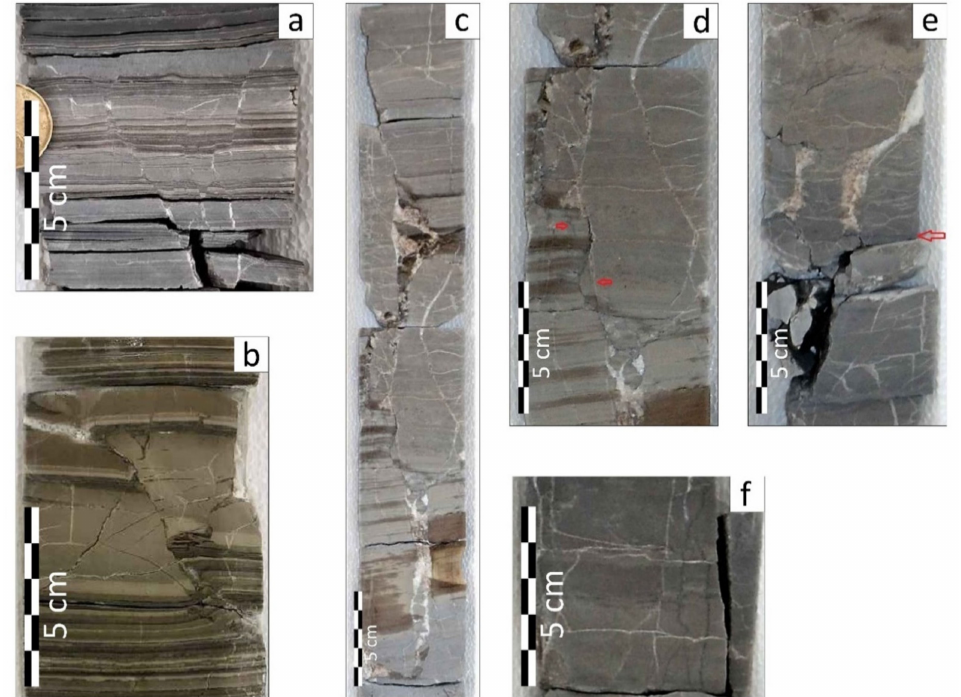
Figure 11. Examples of ( a ) normal micro-faults with small horst and grabens; ( b ) a reverse micro-fault with an 18 mm offset. Partially cemented fractures are also present; ( c ) a portion of the 2111–2112 core containing the normal fault, cemented by calcite and angular clasts, reminiscent of a damage zone; ( d ) a tectonic stylolite cutting a fracture (red arrows indicate stylolites), ( e ) a fracture cutting a load stylolite (red arrows indicate stylolites), and ( f ) sub-vertical tectonic